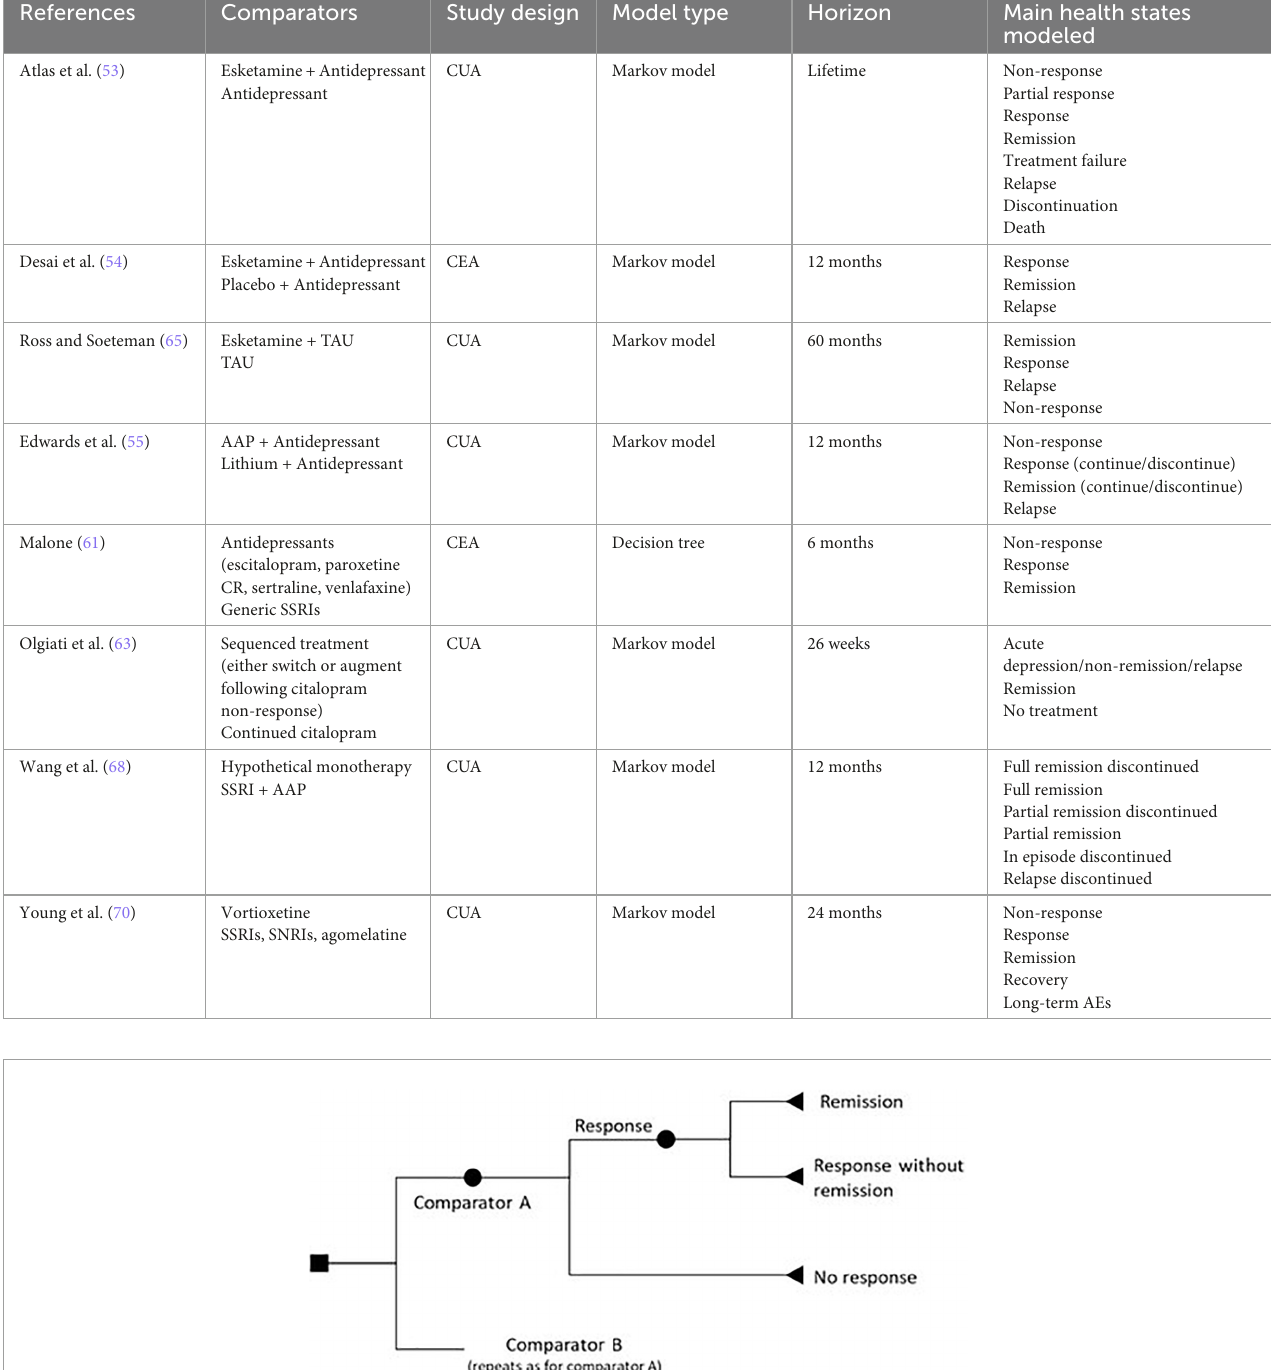
TABLE 3B Model characteristics for economic evaluations of pharmacological interventions.